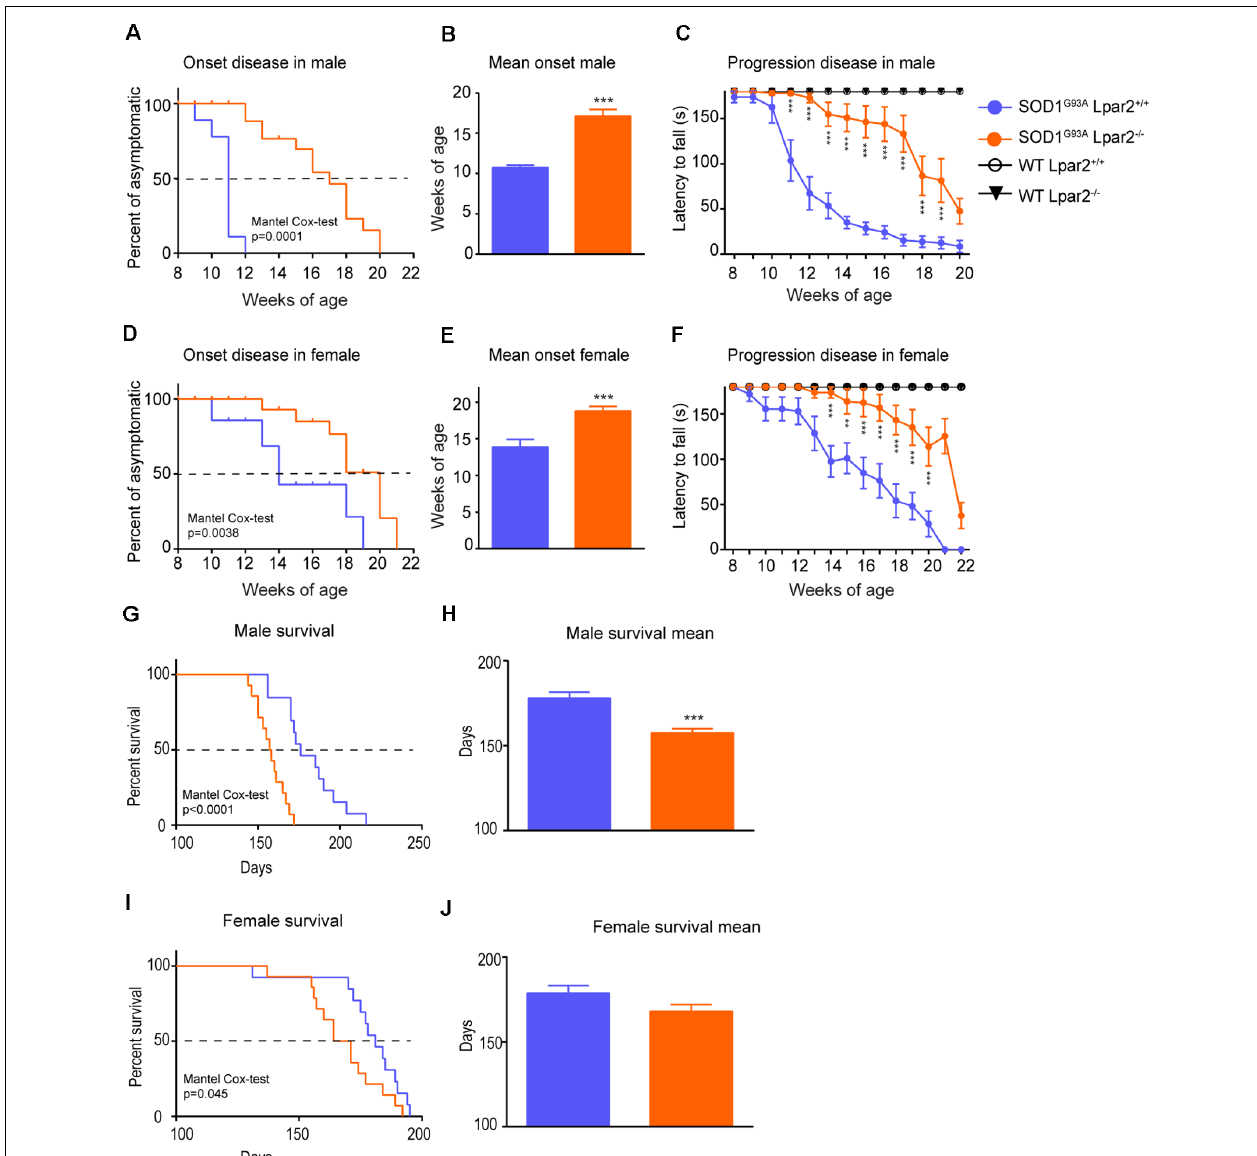
FIGURE 3 | Dual effects of LPA 2 in ALS disease. (A–E) Graphs showing the functional evaluation of ALS mice in the rotarod test over time. (A,B) Lpar2 deficiency delays the onset of the disease in 5 weeks in male ALS mice (A,B) and 4 weeks in females (D,E) . Graphs showing the functional progression of neurological deficits represented by the latency to fall off the rotarod test in males (C) and females (F) . (G–J) Effects of Lpar2 gene deletion in the lifespan of ALS mice. Two-way RM ANOVA, Bonferroni’s post hoc test in (A,B) . Mantel-Cox test in (B,E,G,I) . Unpaired t -test in (C,F,H,J) . (A–C) Males ( n = 9 SOD1 G93A Lpar2 +/+ , n = 11 SOD1 G93A Lpar2 − / − , n = 4 WT Lpar2 +/+ , n = 4 WT Lpar2 − / − ). (D–E) Females ( n = 10 SOD1 G93A Lpar2 +/+ , n = 11 SOD1 G93A Lpar2 − / − , n = 4 WT Lpar2 +/+ , n = 4 WT Lpar2 − / − ). (G–H) Males ( n = 14 SOD1 G93A Lpar2 +/+ , n = 15 SOD1 G93A Lpar2 − / − ). (I–J) Females ( n = 14 SOD1 G93A Lpar2 +/+ , n = 14 SOD1 G93A Lpar2 − / − ). ** p < 0.01, *** p < 0.001, vs. SOD1 G93A LPA 2+/+ . Data are shown as mean ±